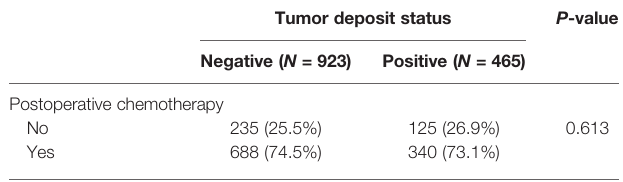
TABLE 1 | Baseline clinicopathological characteristics and the status of tumor deposit in rectal cancer patients.